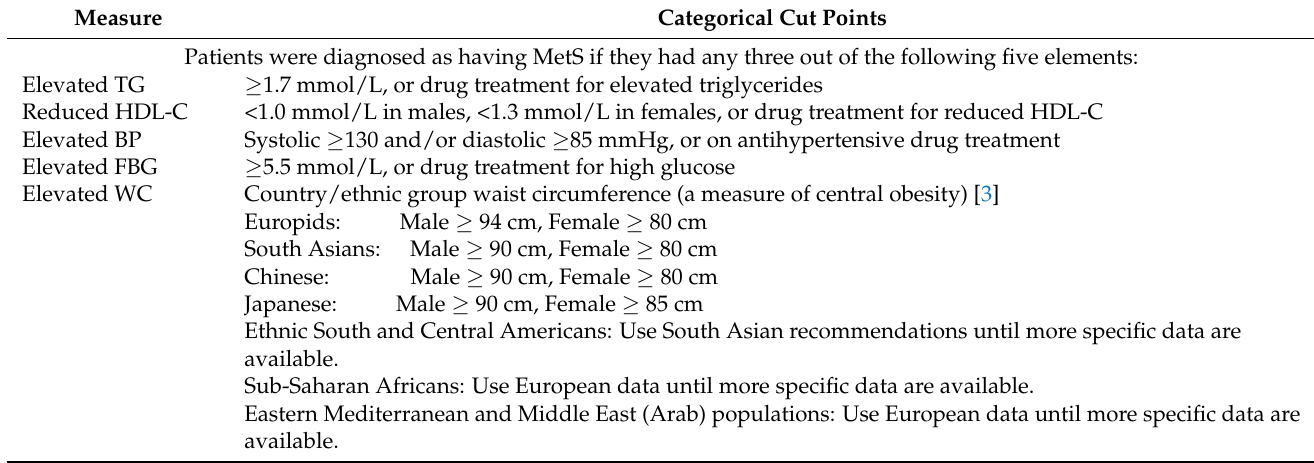
Table 1. Updated criteria for clinical diagnosis of Metabolic Syndrome [6]. Categorical Cut